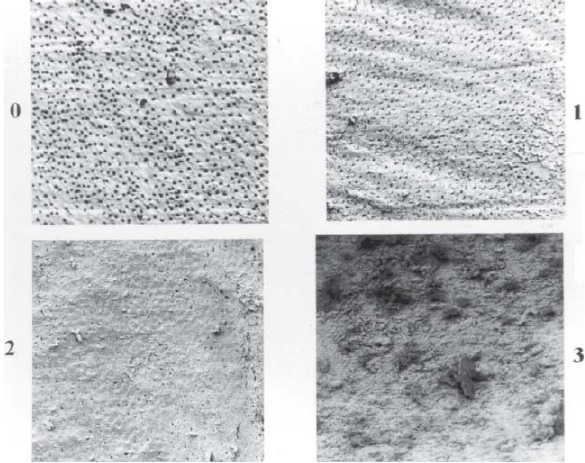
FIGURE 1- Scores used for scanning electron microscopy analysis (500x